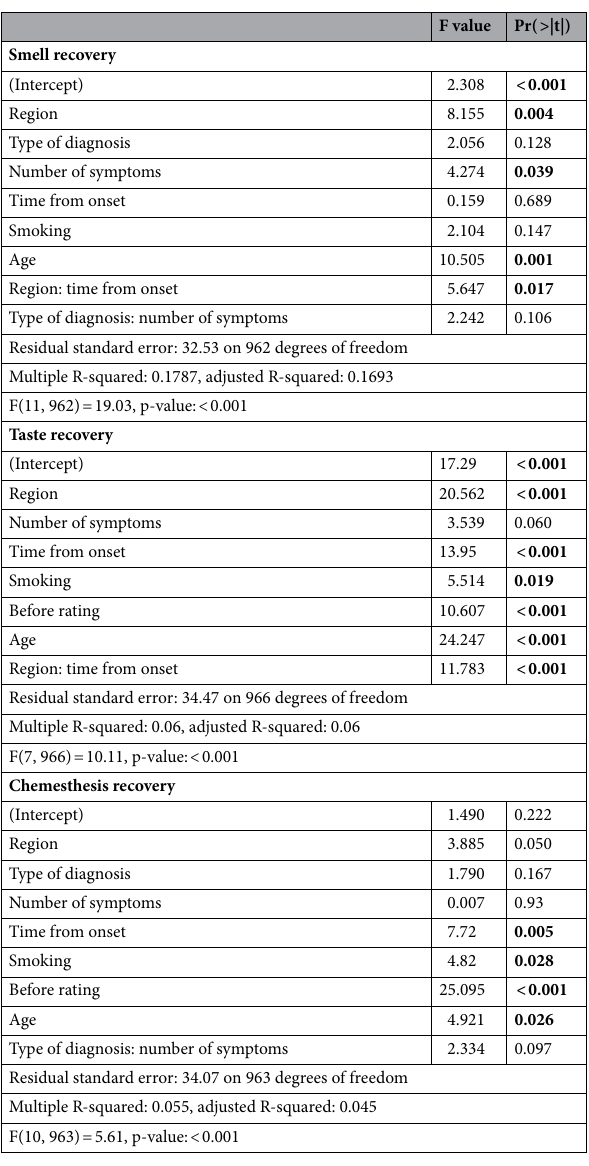
Table 2. Summary of the linear regressions on smell, taste, and chemesthesis recovery. Significant differences are marked in